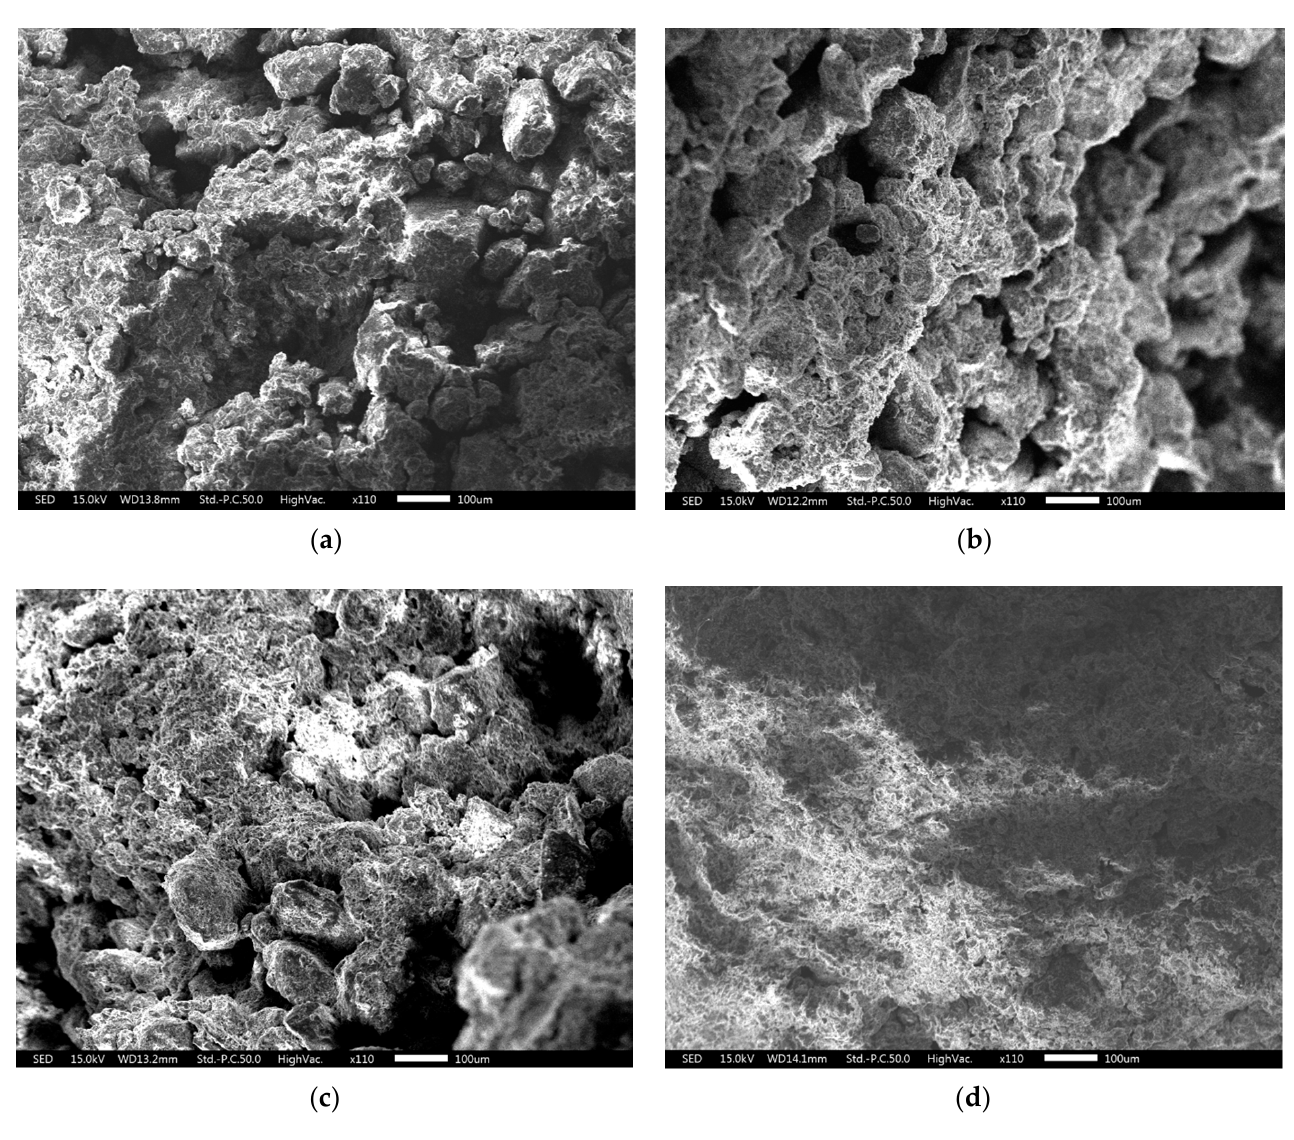
Figure 4. SEM micrographs at 100 µm of ( a )-red clay, ( b )-15% steel slag-modified specimen at 7 days curing, ( c )-15% steel slag-modified specimen at 28 days curing, ( d )-9% cement-modified specimen at 28 days curing.